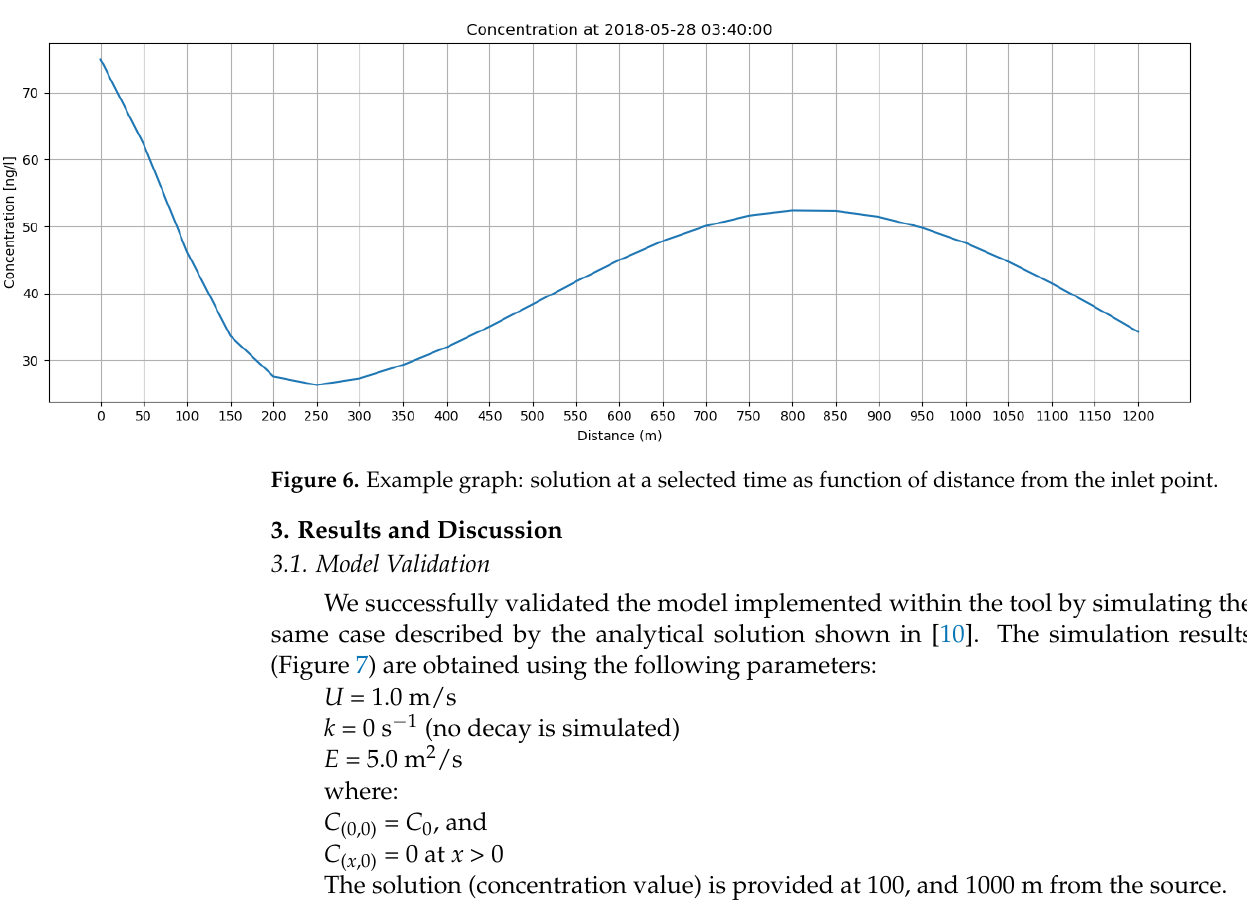
using the GIS selection tools.